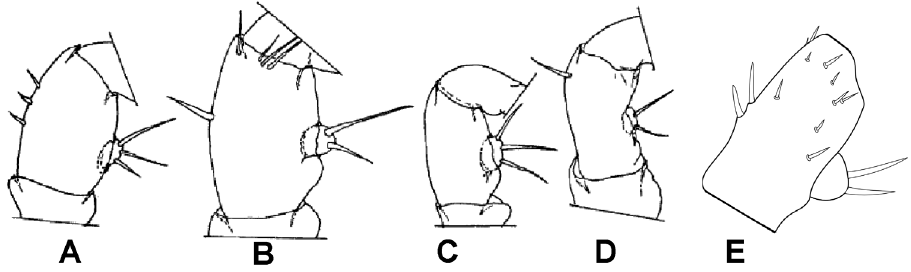
Figure 7. Squama of antenna II of Stenasellus vermeuleni ( A ) S . messanai ( B ) S . henryi ( C ) S . grafi ( D ) and S . tashanensis sp. n. ( E ). (Figures A–D from Magniez and Stock 2000).